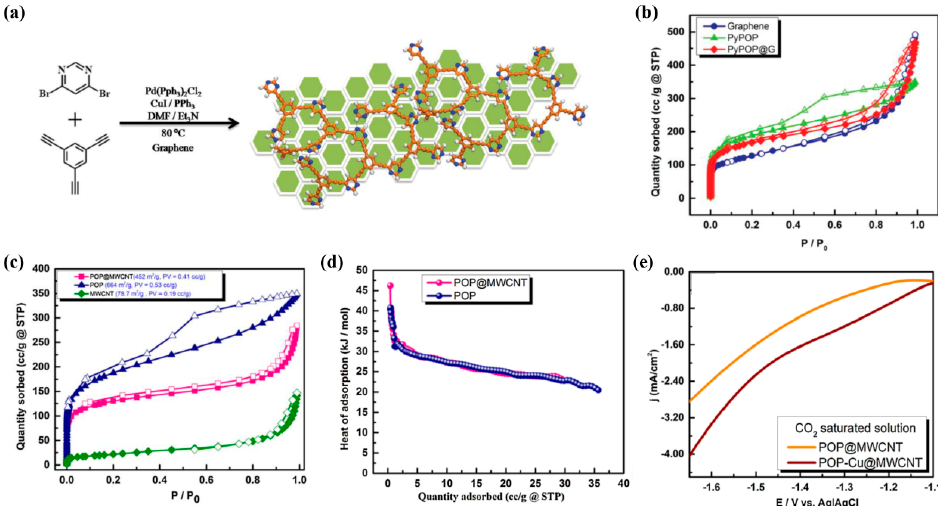
− sorption isotherms for the